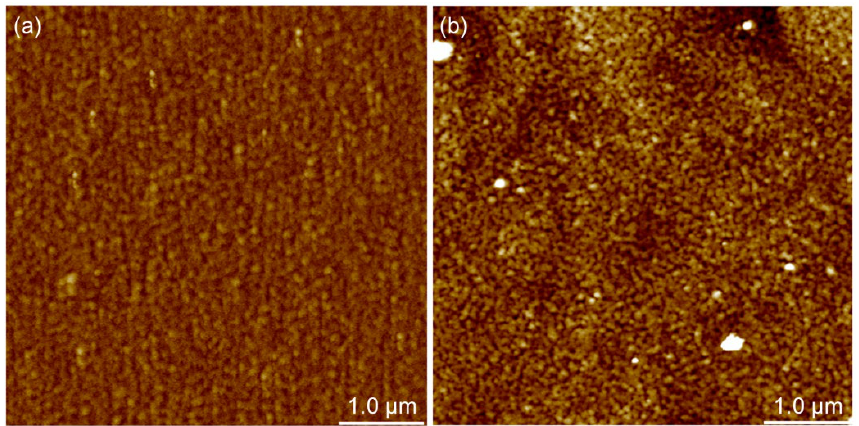
Figure 8. AFM image of 5 μm × 5 μm surface of PAH/PAA multilayer made of 5 bilayers on ( a ) Si substrate and ( b ) Ti substrate. The higher areas are shown in a lighter color; z-scale value is 20 nm.